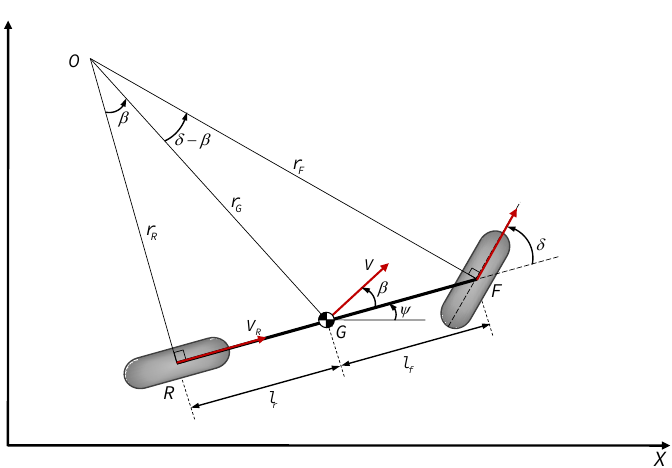
Figure 1. Bicycle model diagram of lateral vehicle dynamics.